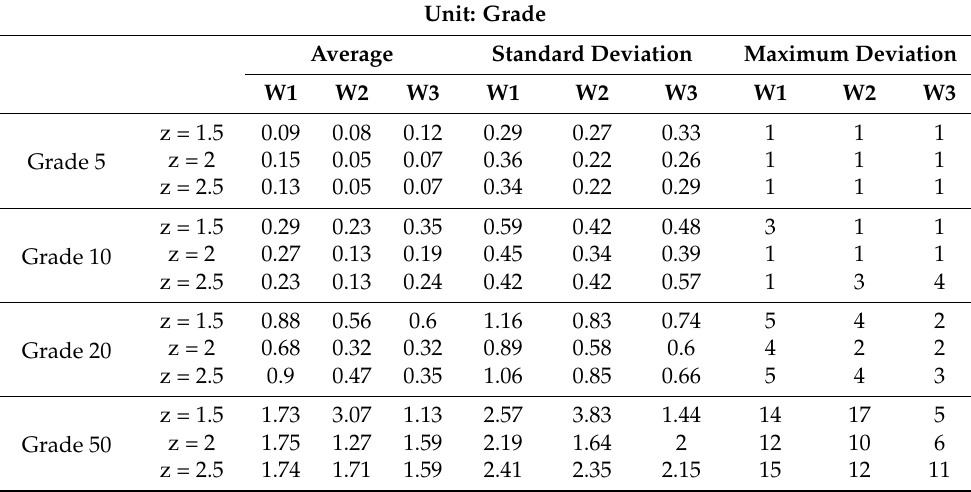
Table 8. Relation of average, standard and maximum deviation in three width, z-scores and grades. Unit: Grade Average Standard Deviation